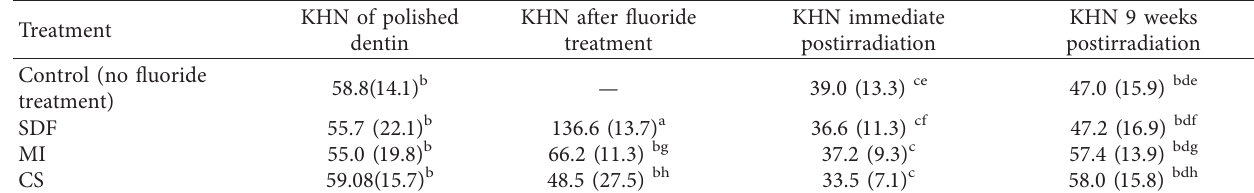
Table 3: Effect of irradiation on KHN of dentin.